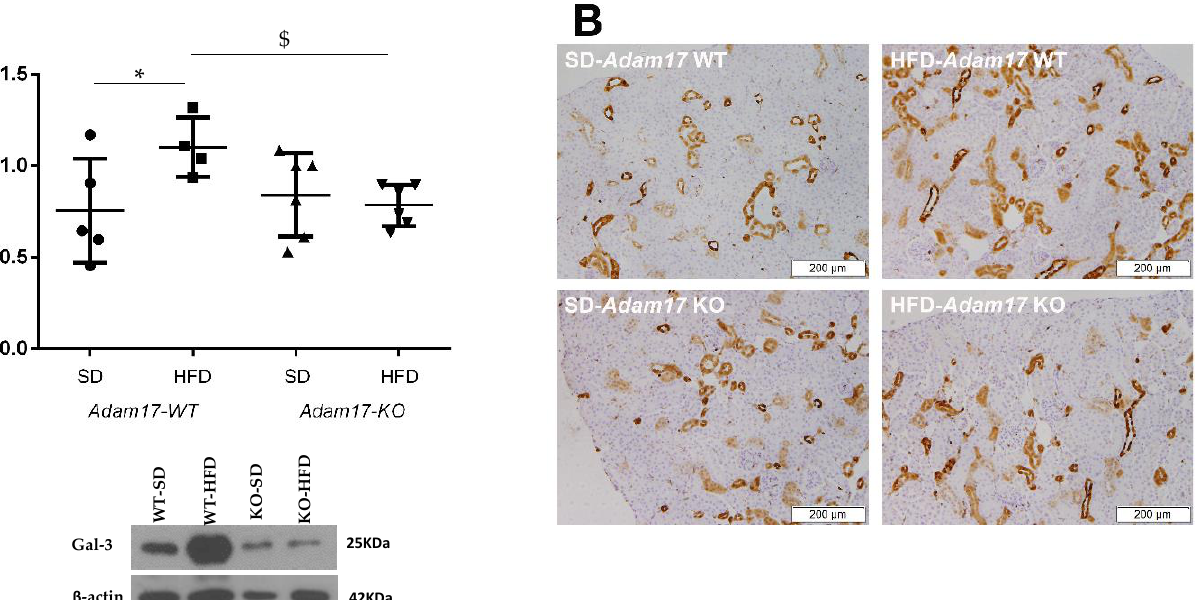
Figure 4. Influences of HFD and endothelial Adam17 deletion on galectin-3 expression. ( A ) Galectin-3 expression measured by Western blot ( n = 4–6). ( B ) Representative images of galectin-3 immunostaining. 100× magnification, scale bar 200 μ m.